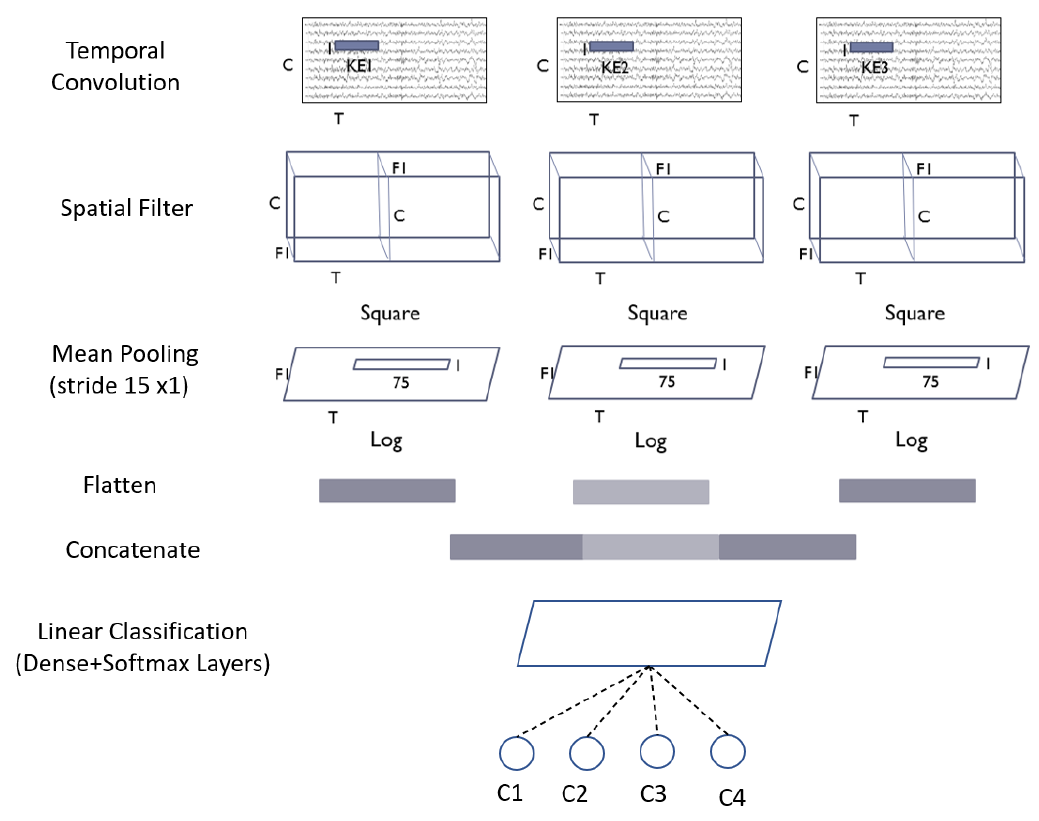
Figure 6. Architecture of MBShallowConvNet model.